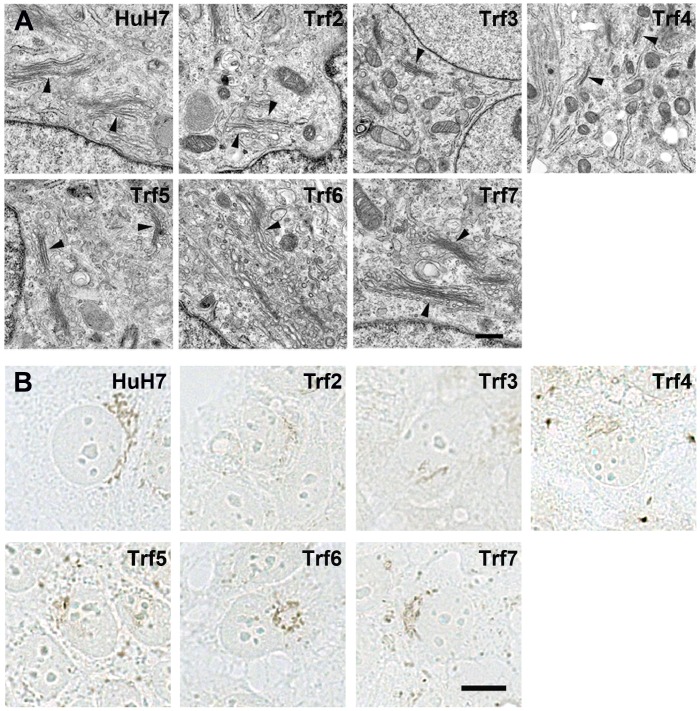
The Golgi apparatus in Trf mutants.(A) Representative EM images showing perinuclear Golgi apparatus membrane stacks (arrowhead) in HuH7 and Trf mutant cells. Scale bar: 0.5 µm. (B) Representative histochemical staining of the Golgi apparatus lumen with TPPase substrate. Scale bar: 10 µm.